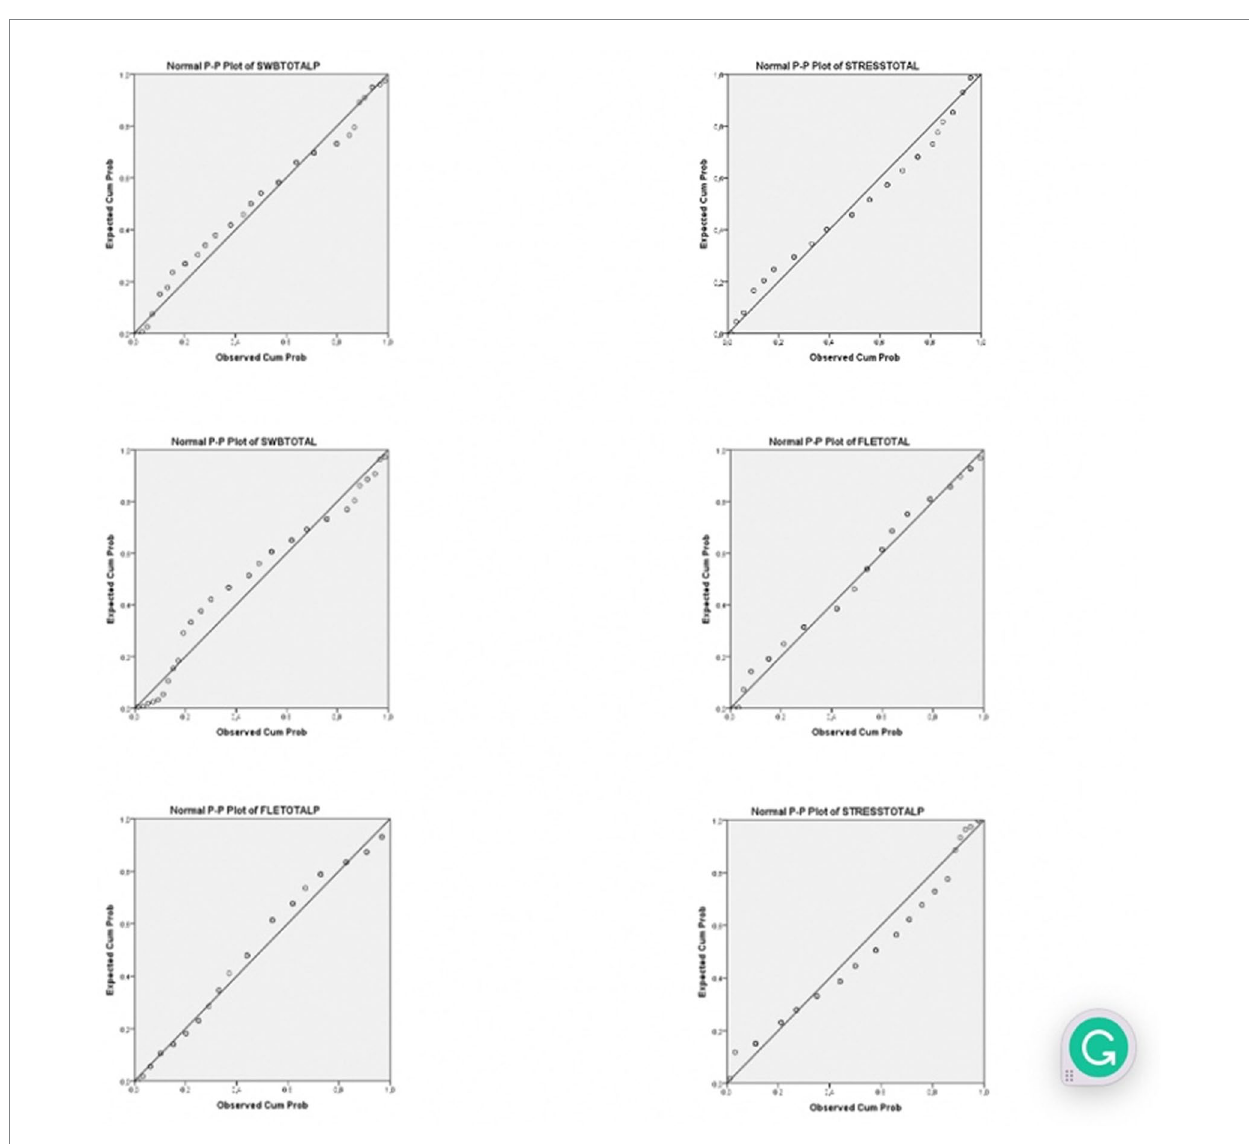
FIGURE 1 P-P plots for normal distribution.